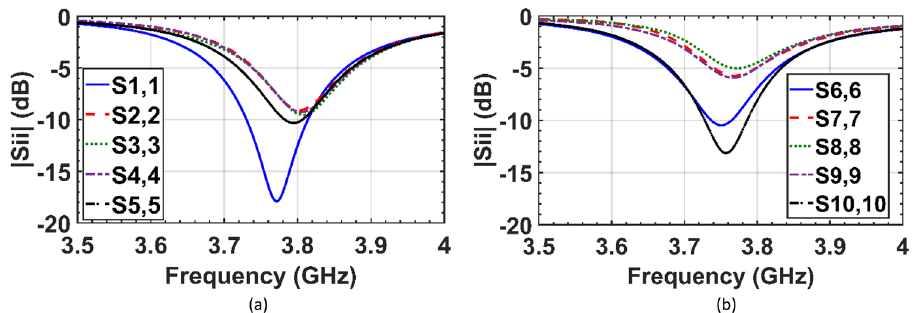
Figure 7. Simulated reflection coefficients of the interleaved elements of the ( a ) uncloaked array I, and ( b ) uncloaked array II.